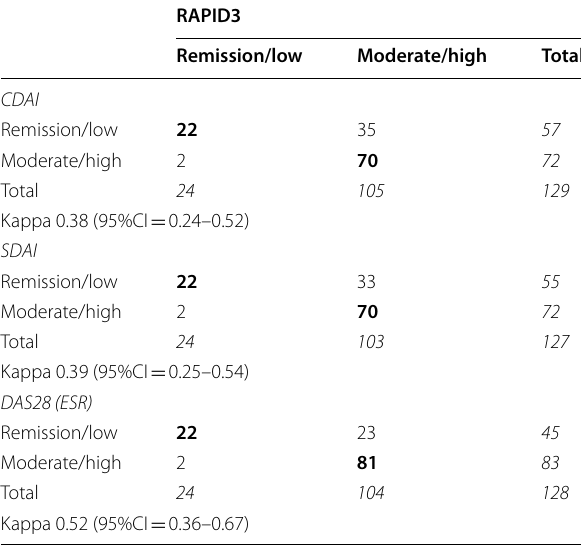
Table 4 Agreement between the categories grouped in RAPID3,